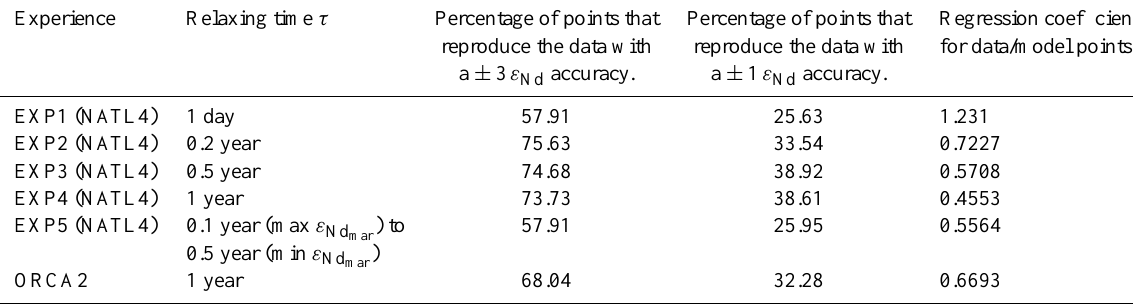
Table 1. Summary of the main characteristics for each experiment. Experience Relaxing time τ Percentage of points that Percentage of points that Regression coefficient reproduce the data with reproduce the data with for data/model